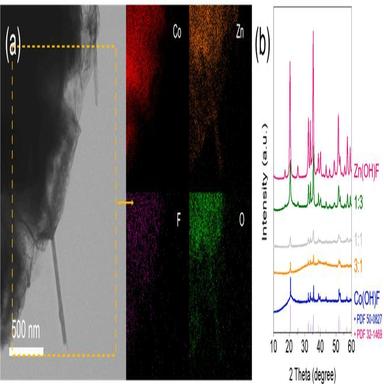
(a) A STEM image and the EDS mapping images of the heterostructures (3:1). (b) XRD patterns of the Co(OH)F microflowers, Zn(OH)F nanorods, and the heterostructure materials with mixing ratios of 3:1, 1:1, and 1:3.